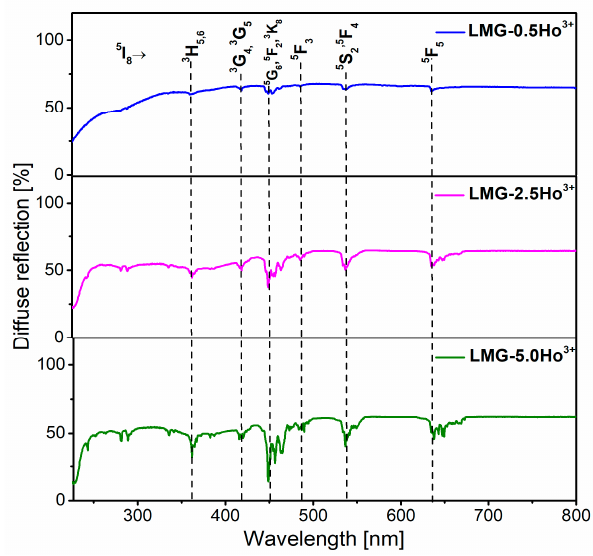
Figure 3. Reflectance spectra of LMG-0.5Ho 3+ , LMG-2.5Ho 3+ , and LMG-5.0Ho 3+ .